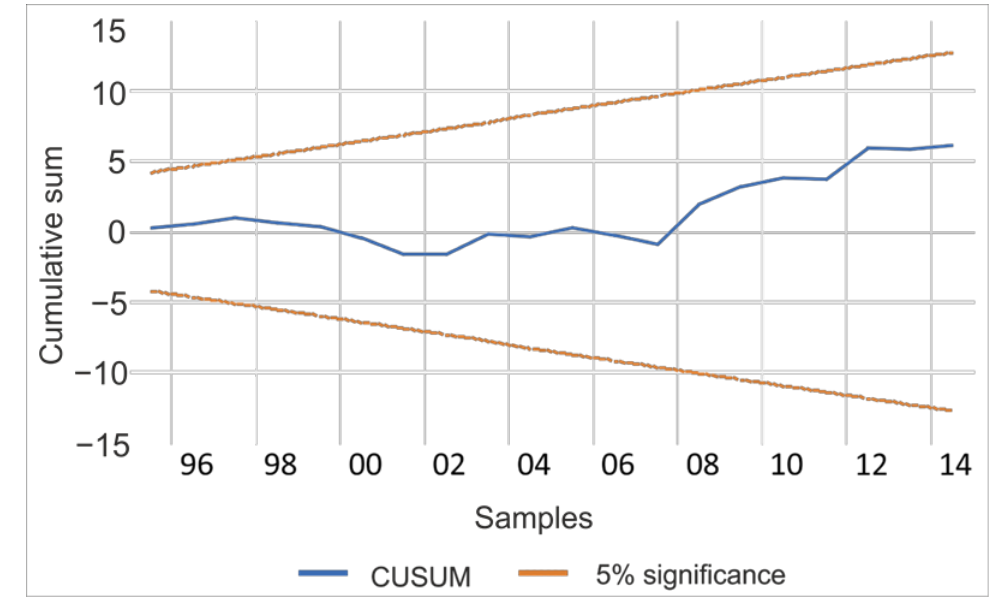
Figure 2. Stability test.